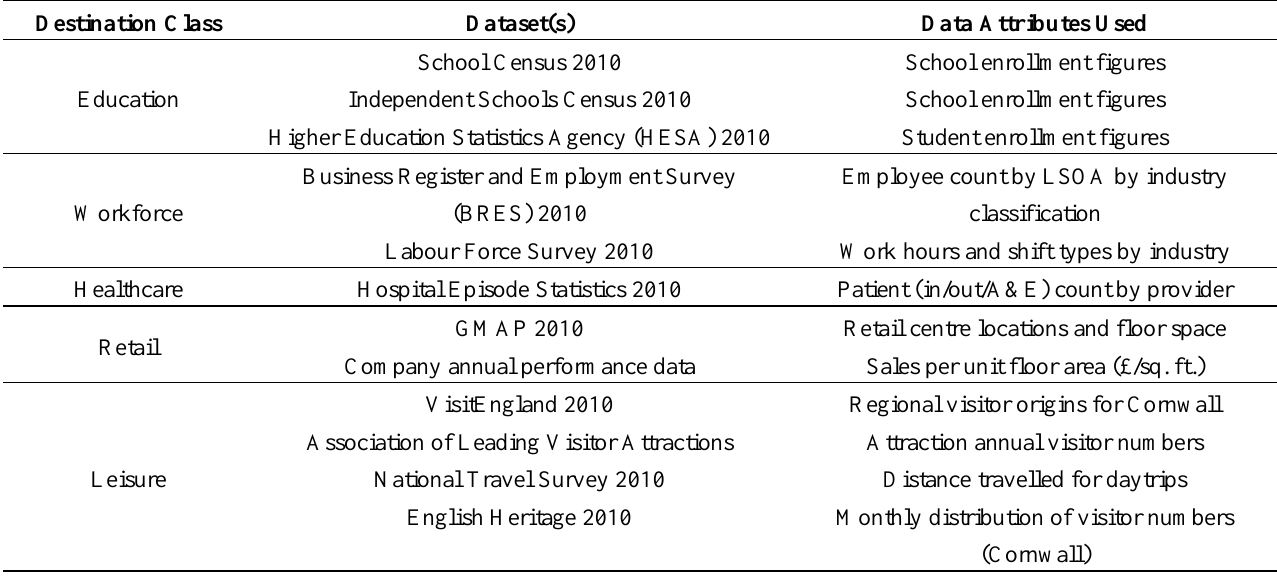
Table 1. Datasets used to construct destination